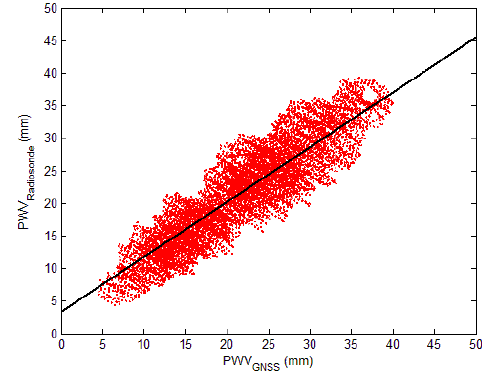
Figure 5. Correlation of GNSS-estimated PWV and radiosonde results at GISM station